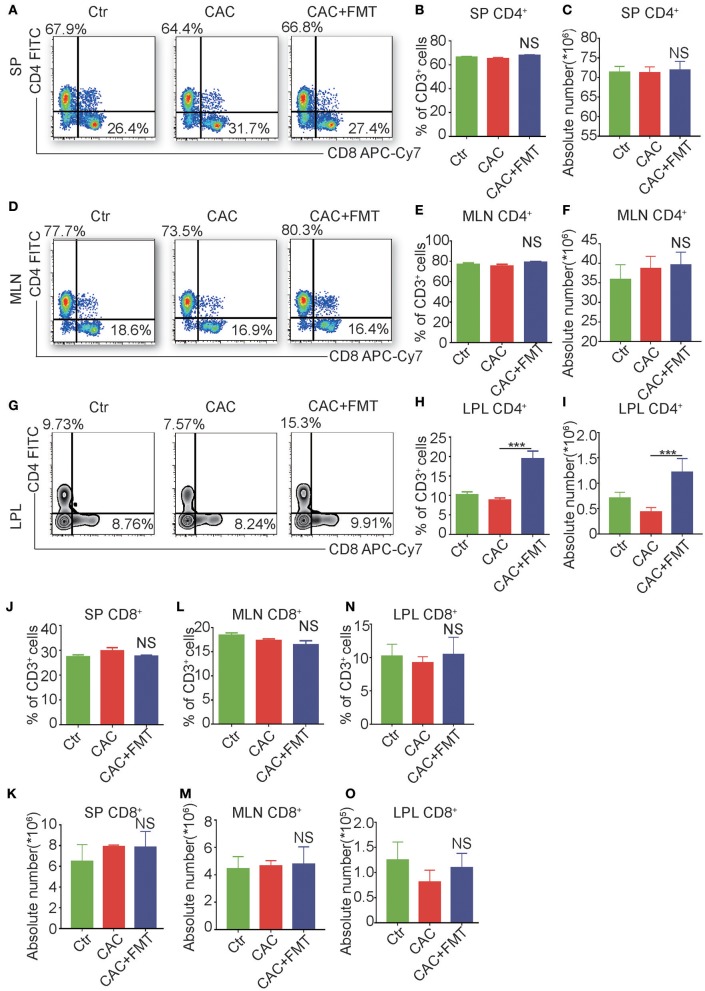
Fecal microbiota transplantation (FMT) treatment promotes CD4+ T cells but not CD8+ T cells in lamina propia lymphocytes (LPLs). (A–O) Single-cell suspensions of mouse LPL, mesenteric lymph nodes (MLN), and spleens from each group were prepared. Cells were stained with CD3-Percp-Cy5.5, CD4-FITC, CD8-APC-Cy7 for FACS analysis of CD3+CD4+ T cells (Th cells) or CD3+CD8+ T cells (Tc cells). Representative FACS gates from spleen (A), MLN (D), and LPL (G) are presented. The proportion and absolute numbers of Th cells (B,C,E,F,H,I) or Tc cells (J–O) in CD3+ T cells from splenocytes (B,C,J,K), MLN (E,F,L,M), and LPL (H,I,N,O) from each group were analyzed by FACS. Data are expressed as the mean ± SD of six mice for each group from one representative experiment. All experiments were repeated three times with similar results. ***P < 0.001 (ANOVA/LSD).